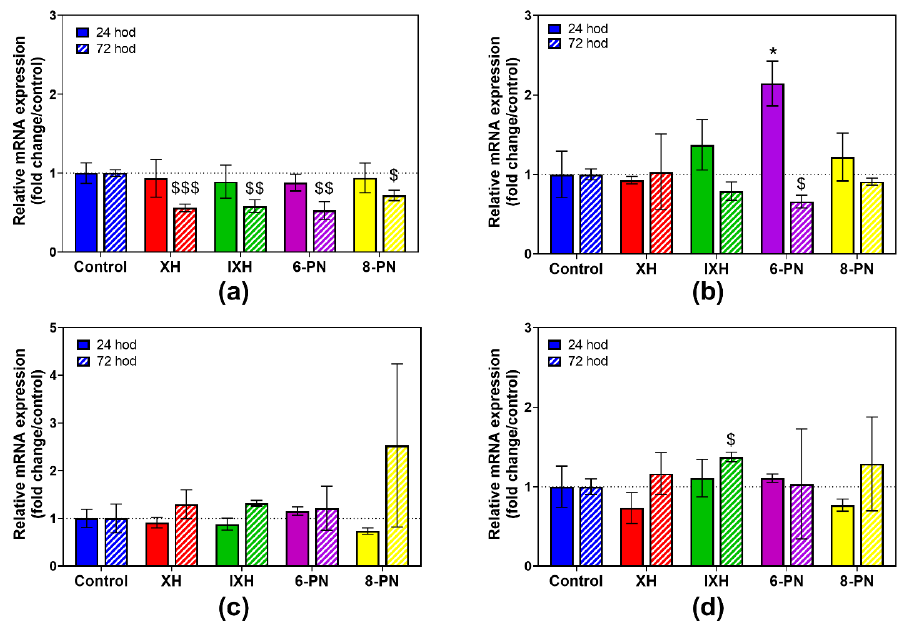
Figure 2. The effect of prenylflavonoids (1 µM) on the normalized mRNA expression of GSTA1/2 ( a ), GSTP1 ( b ), SULT1A1 ( c ) and COMT ( d ) in proliferating CaCo-2 cells after 24 h and 72 h ( n = 3). The normalized expression level was calculated using the 2 −ΔΔCt method with the geometric mean of glyceraldehyde 3-phosphate dehydrogenase (GAPDH) and beta-2 microglobulin (B2M) as a reference gene. Results are presented as the mean ± SD of three independent experiments. Statistical analyses were performed using a one-way ANOVA with Dunnett ’ s test: p < 0.05 (* or §), p < 0.01 (§§), p < 0.001 (§§§); * different from control after 24 h, $ different from control after 72 h.